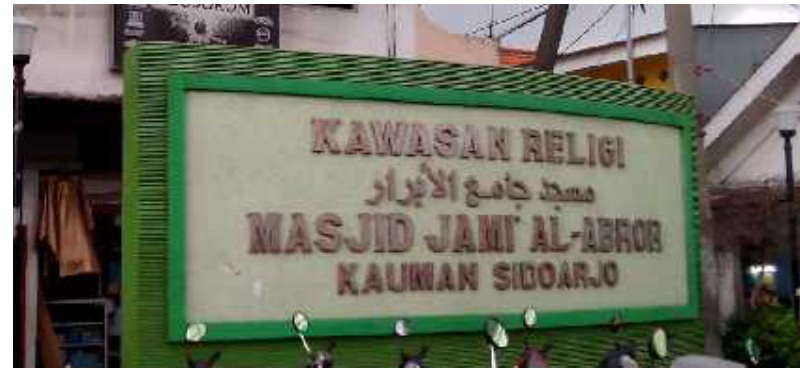
Figure 9. Masjid Jami’ Al-Abror